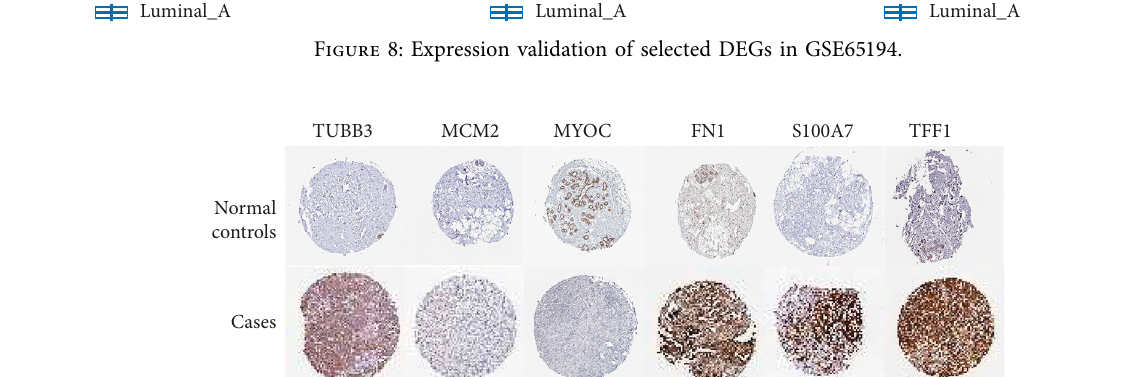
Figure 9: Protein expression validation of selected DEGs in The Human Protein Atlas